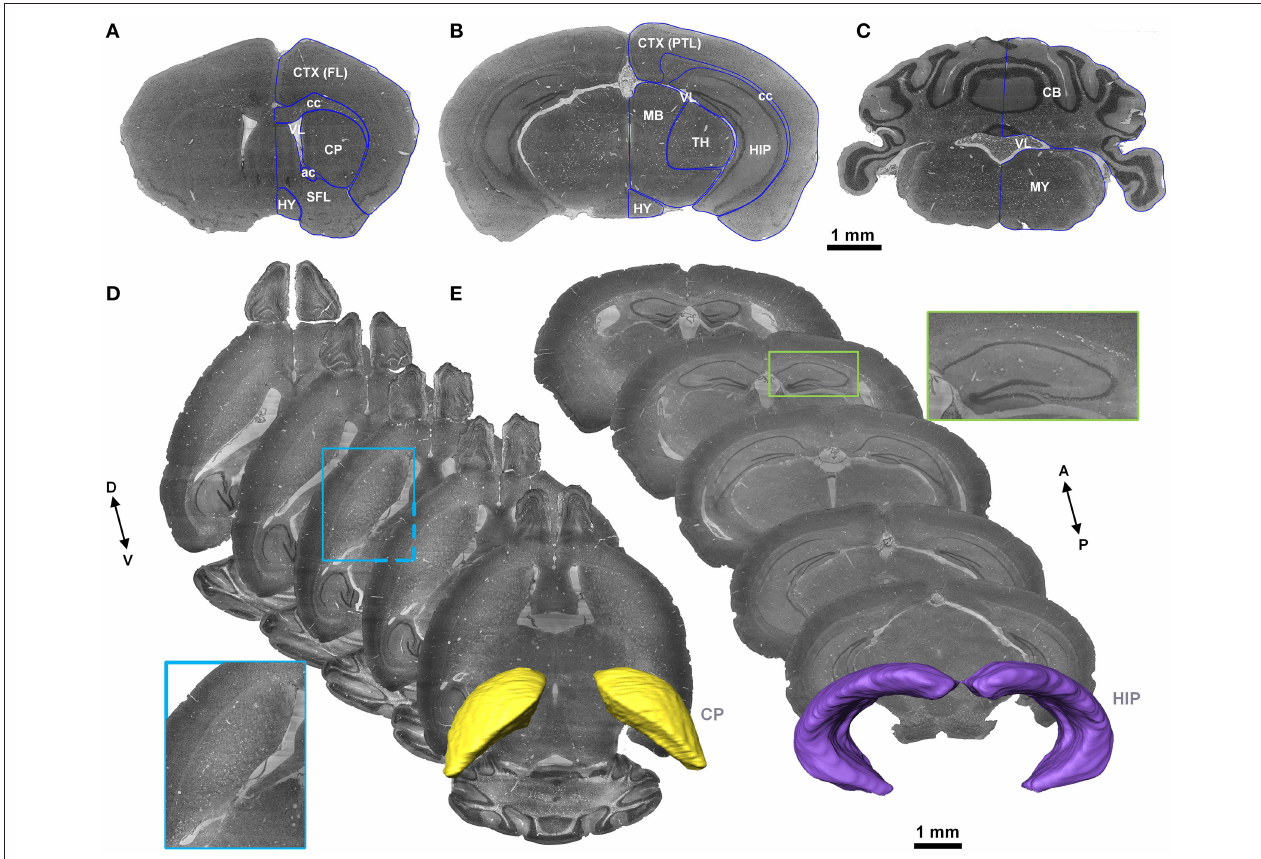
FIGURE 2 | Segmentation of the brain regions. (A–C) The representative coronal sections in the same mouse brain. The blue lines represent the contour of the brain regions segmented manually. (D,E) Horizontal sections with a distance of 300 µ m to present contour indicated by cytoarchitecture of the CP and coronal sections with a distance of 500 µ m to present contour indicated by cytoarchitecture of the HIP are presented. The images in the blue and green boxes are local, enlarged views of the CP and HIP, respectively. The 3D structures in yellow and violet are the constructed contours of the CP and HIP, respectively. A, anterior; P, posterior; D, dorsal; V, ventral. A list of abbreviations and the full names of the brain regions is presented in Supplementary Table